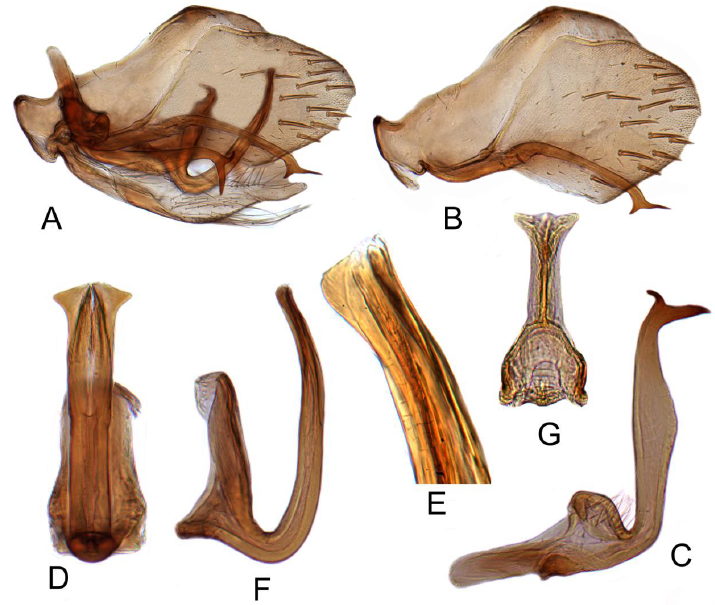
Figure 12. Batracomorphus lunatus Cai and He, 2001: ( A ) genital capsule in lateral view; ( B ) pygofer side and pygophore processes; ( C ) styles; ( D ) aedeagus, ventral view; ( E ) aedeagus apex, lateral view; ( F ) aedeagus apex, lateral view; ( G ) connective.